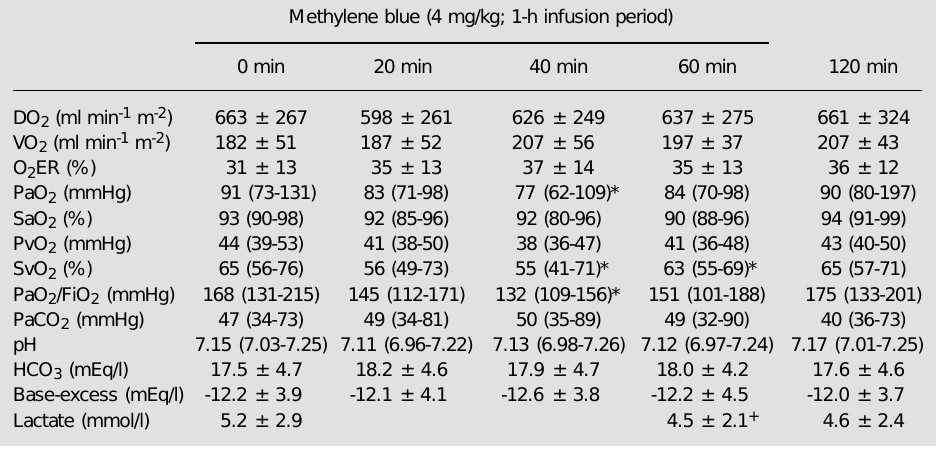
(min)100Figure 3 - Time course of mixed venous saturation (Sv) (top) and PaO 2 /FiO 2 (bottom) after intra- venous administration of meth- ylene blue (4 mg/kg) after baseline (time 0) in 10 septic shock patients. Mixed venous saturation significantly de- creased from baseline at 40 and 60 min (P<0.05). The PaO 2 /FiO 2 ratio decreased significantly from baseline at 40 min (*P<0.05 from time 0). The box plot lines indicate the median and 25th and 50th percentiles, and error bars indicate the 10th and 90th percentiles. The circles indicate the extreme